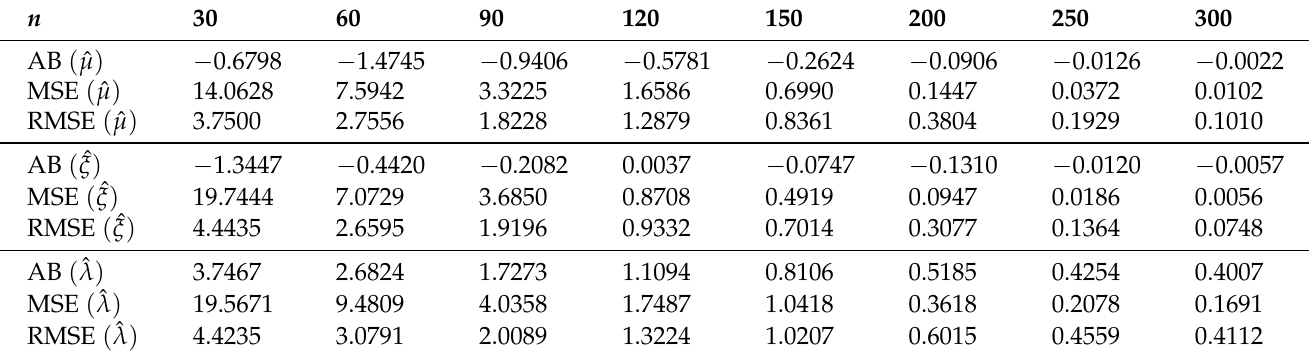
Table 1. Numerical outcomes of AB and MSE values of the NIGT-II model for µ = 2.7, ξ = 3.9, λ =